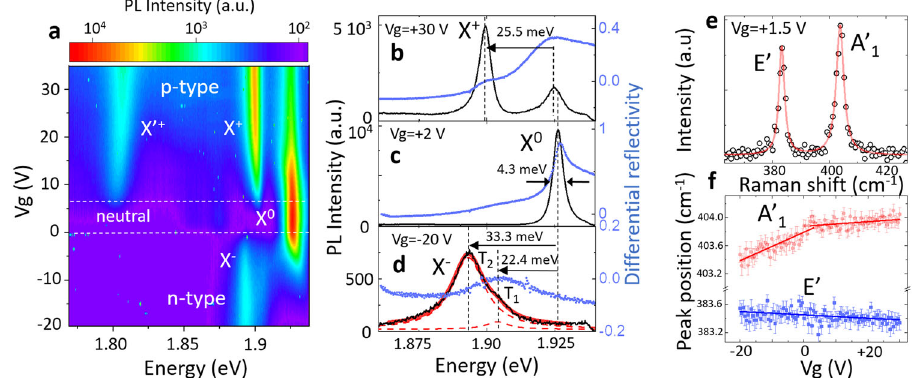
Fig. 2 Optical characterization of a charge tunable MoS 2 monolayer. a Photoluminescence (PL) intensity on a logarithmic scale under continuous wave (cw) laser excitation at 10 μ W as a function of photon emission energy and gate bias V g . b PL spectrum at a gate voltage corresponding to the p-type regime. c PL spectrum at a gate voltage corresponding to the neutral regime. d PL spectrum at a gate voltage corresponding to the n-type doping regime. Also shown is the differential re fl ectivity spectrum ( fi lled dots) for each case. e Raman spectrum in the neutral regime, exhibiting the well-known E' and A' 1 vibrational modes. f Peak position for both modes of panel ( e ) as a function of gate bias. The error bars correspond to the uncertainty given by the fi tting of the Raman spectrum with a double